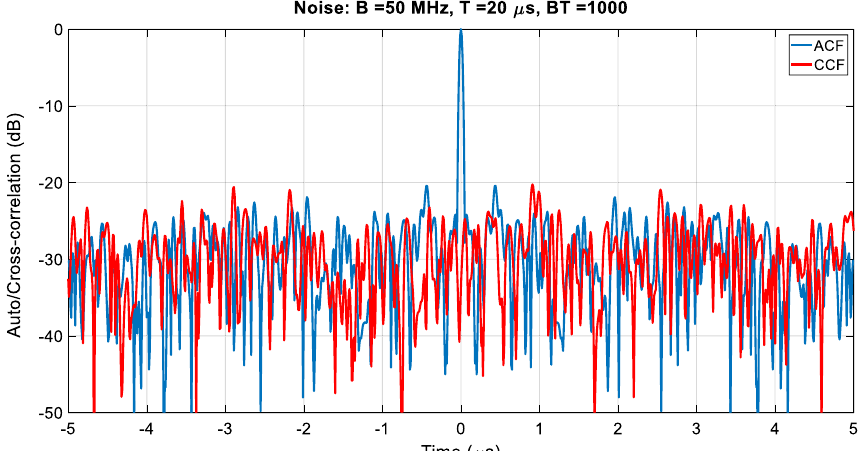
Fig. 8 ACF and CCF between two exemplary noise waveforms: B